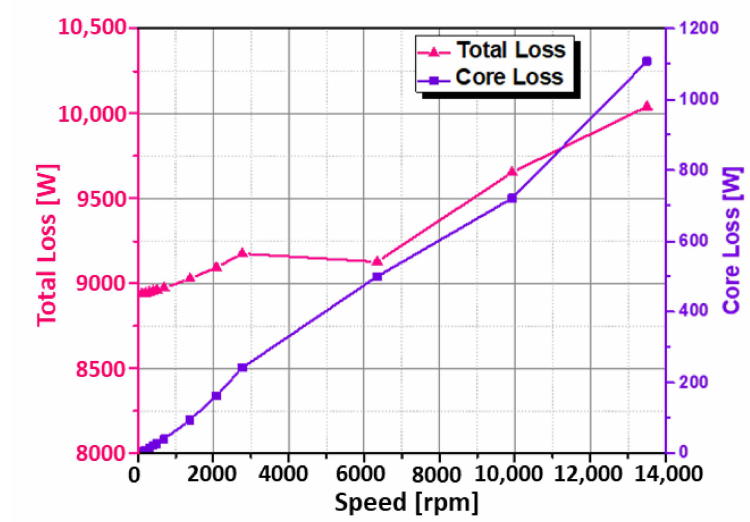
Figure 15. Copper and core loss vs. speed.